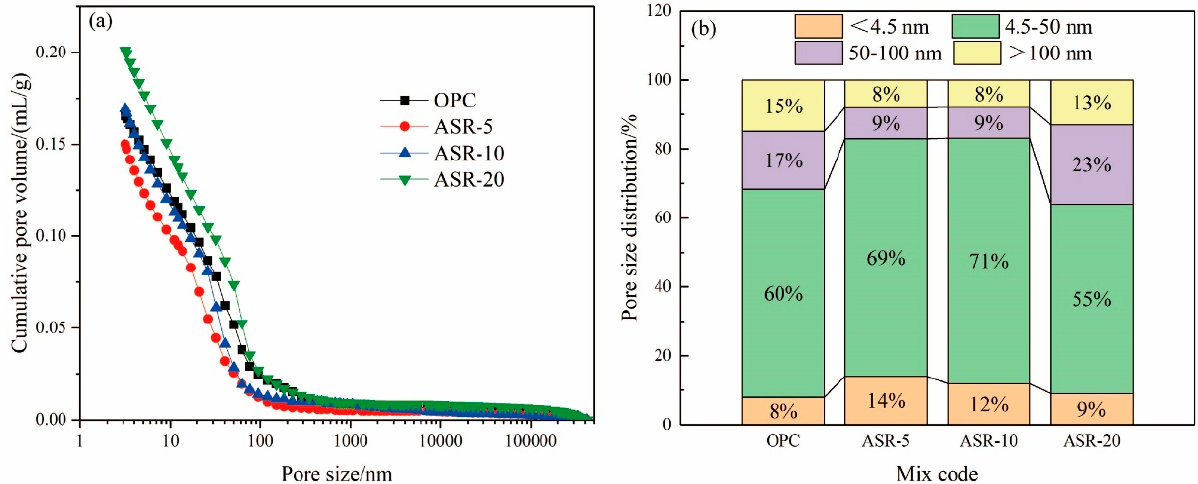
Figure 7. Pore structures of the ASR-cement hardened pastes after 3 days. Cumulative pore volume ( a ); pore size distributions ( b ).